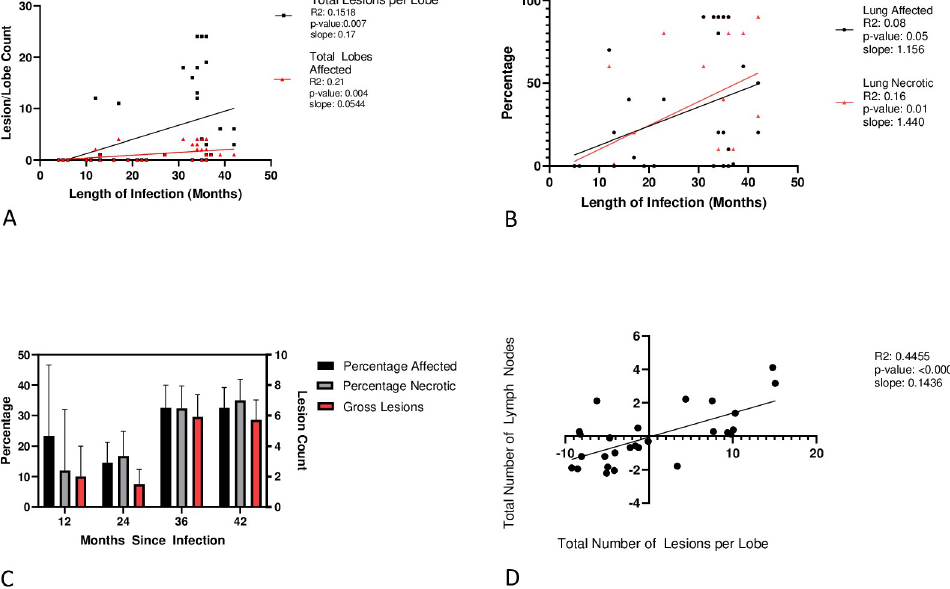
Fig 2. Gross and Histopathological Progression of Bovine Tuberculosis A. Gross Lesions within the Lungs: Simple linear regression showing the correlation between number of lesions in all lung lobes and number of lobes grossly affect with length of